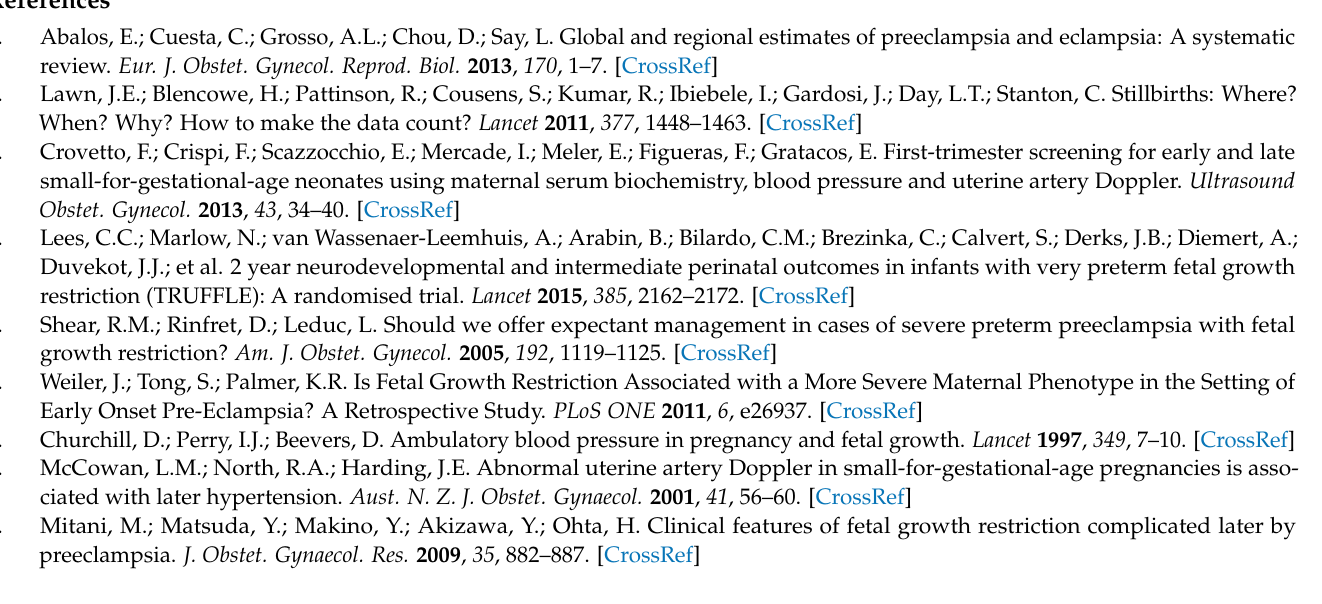
Table 10. In our study blood samples were collected directly before the delivery, which was performed within the next 48 h from the moment of venipuncture, due to maternal or fetal clinical decompensation, when the differences in terms of angiogenic imbalance are maximized, while many studies concentrate on prediction or moment of diagnosis in suspected PE cases, when changes in angiogenic profile are less pronounced in late- onset disease. It was only found in one work that was focused on angiogenic factor levels within one week prior to delivery in similar cohorts—iPE, iFGR and those entities combined together by Nanjo et al. The results regarding concentrations of PlGF, sFlt-1 and sEng in investigated subgroups were exactly the same as those presented by Japanese authors. This study has certain limitations. It was done in a single center and it is of relatively small size. This is why we did not separate early-onset from late-onset patients in study cohorts for deeper analysis. Although there was an interested in all preeclampsia-related adverse outcomes, rare but meaningful adverse outcomes such as pulmonary edema, DIC or maternal death, were not observed in the